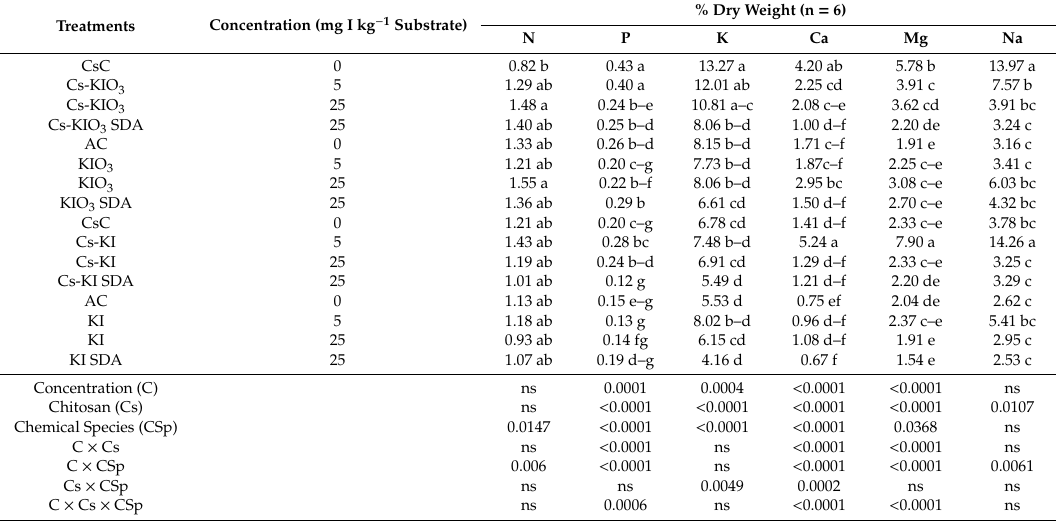
Table 2. Macroelement contents in mixed samples of lettuce leaves and heads. Treatments